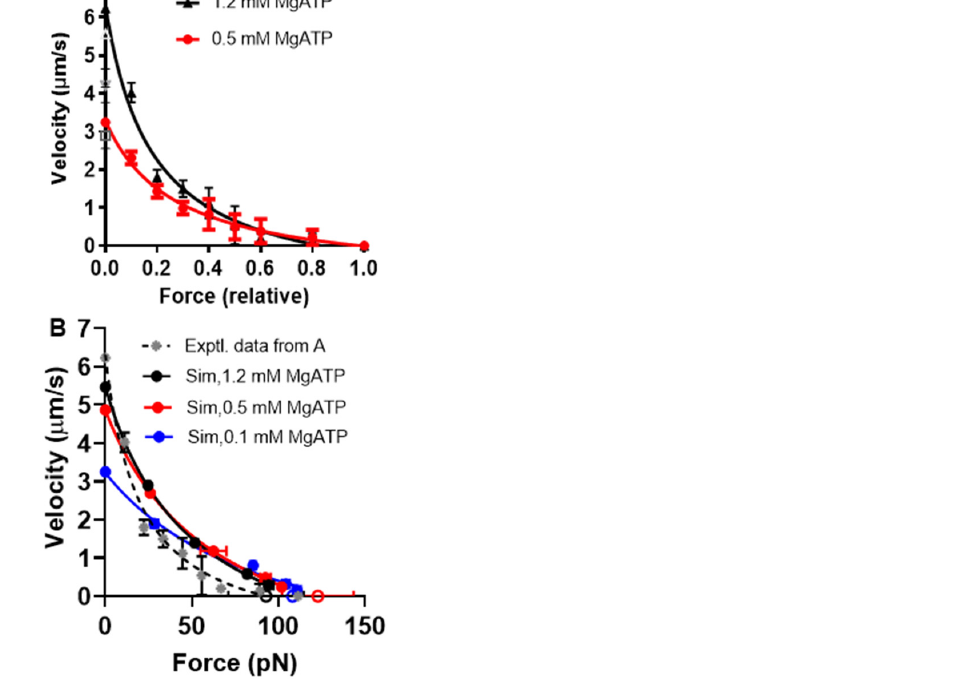
Figure 9. FV relationship at different [MgATP] levels—experiments and simulations. ( A ) Ex- perimental data from Cheng et al. [70] from myosin filaments interacting with actin filaments at approximately 22 ◦ C and either 1.2 mM (black) or 0.5 mM (red) MgATP. Force data normalized to F 0 . Measured F 0 in experiments at 1.2 mM MgATP: 112.4 ± 11.0 pN/µm ( n = 12) and at 0.5 mM MgATP: 54.5 ± 3.6 pN/µm ( n = 8). Data shown as mean ± standard error of the mean (SEM). Experimental data fitted by Hill’s equation (see Materials and Methods) with a/F 0 * = 0.27 at 1.2 mM MgATP and 0.40 at 0.5 mM MgATP. ( B ) FV data for 1.2 mM (black), 0.5 mM (red), and 0.1 mM (blue) MgATP simulated using Monte Carlo approach described in the text. Simulated data superimposed on ex- perimental data (“Exptl.”, stars and dashed line) at 1.2 mM MgATP from A. Simulated data shown as mean ± SEM; n = 2 except for isometric force (open symbols), where n = 10, due to variability in average force between simulation runs. Simulated data (except point at F 0 ) fitted by Hill’s equation with a/F 0 * = 0.46 at 1.2 mM MgATP, 0.54 at 0.5 mM MgATP, and 0.74 at 0.1 mM MgATP. The lower curvature of the FV relationship at 1.2 mM MgATP that we observed in the simulations compared to the experimental data in Figure 9 may be related to the ten- dency of our small ensemble simulations to predict lower curvature of the relationship (Figure 7). However, it is also important to keep in mind the substantial variabilities be- tween labs in terms of force–velocity data for both isolated proteins and muscle cells (Fig- ure 10). A discrepancy between the experimental data and model predictions that is worth noting is an appreciably lower F 0 at lowered [MgATP] levels in the experiments (see leg- end of Figure 9 and [70]). In contrast, the model predicts increased F 0 with reduced [MgATP], both in the large ensemble version in Figure 6 and in the small ensemble (Monte Carlo) version in Figure 9. These predictions are consistent with previous results where the effects of varied [MgATP] were studied using skinned muscle cells [54,55]. For in- stance, in the study of Cooke and Bialek [55] using glycerinated rabbit psoas fibers, the force increased after lowering MgATP from 1 mM to 50 µM, where a maximum was ob- served for F 0. Further reductions in [MgATP] led to a drop in F 0 . Presumably, the basis for the opposite effects in the filament experiments in Figure 9 is the way the isometric force is attained via the appreciable sliding of the filaments past each other. It is possible that